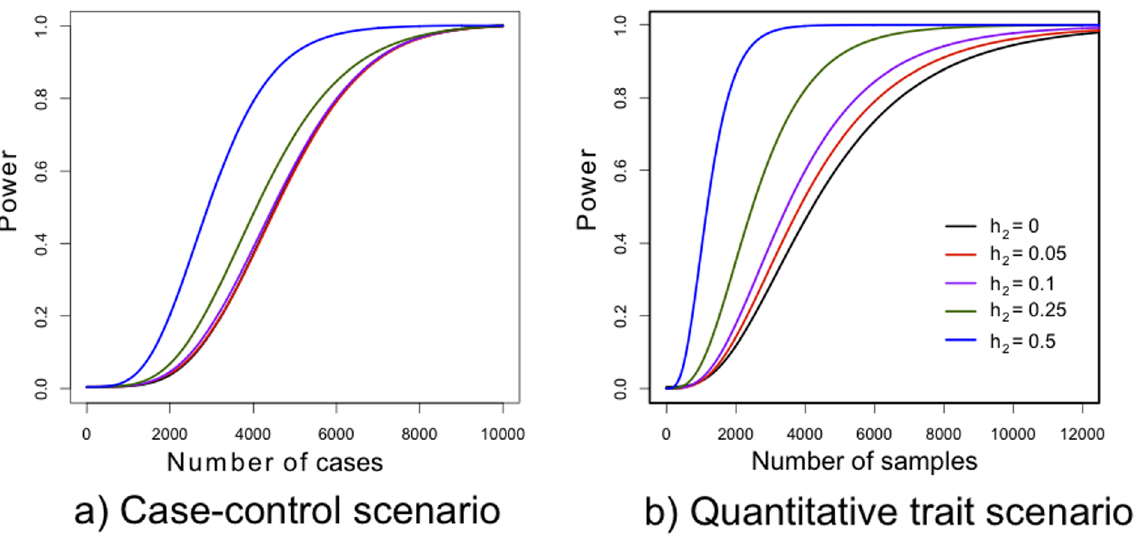
Figure 2. Improvement in power curves gained by prioritising samples based on genetic risk scores with different predictive powers. The color of the line represents the proportion of total variance capture by the risk score, with the black line representing a random (i.e. non-prioritised) selection of samples. a) A case-control scenario for a disease with 1% prevalence. The total cohort size for prioritisation is 10,000 cases and an equal number of controls, and we measured power to detect a risk allele with an odds ratio of 2 and a frequency of 1% at genome-wide significance. b) A quantitative trait scenario. The total cohort size is 100,000, and we measured power to detect an allele with 1% frequency that increased a normally-distributed quantitative trait by 0.2 standard deviations. Power is calculated using the trend test power equations given by Freidlin et al [36].